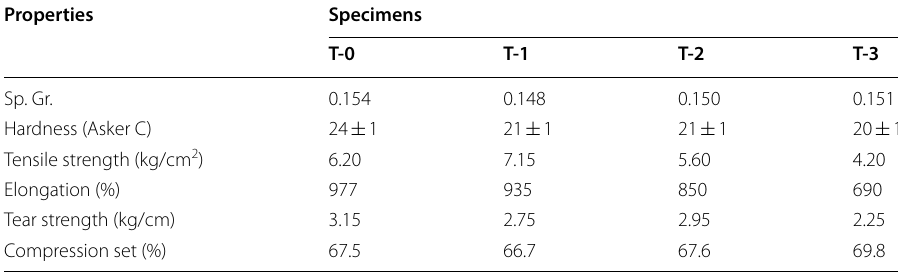
Table 1 Physical and mechanical properties of bio-EPDM foam with